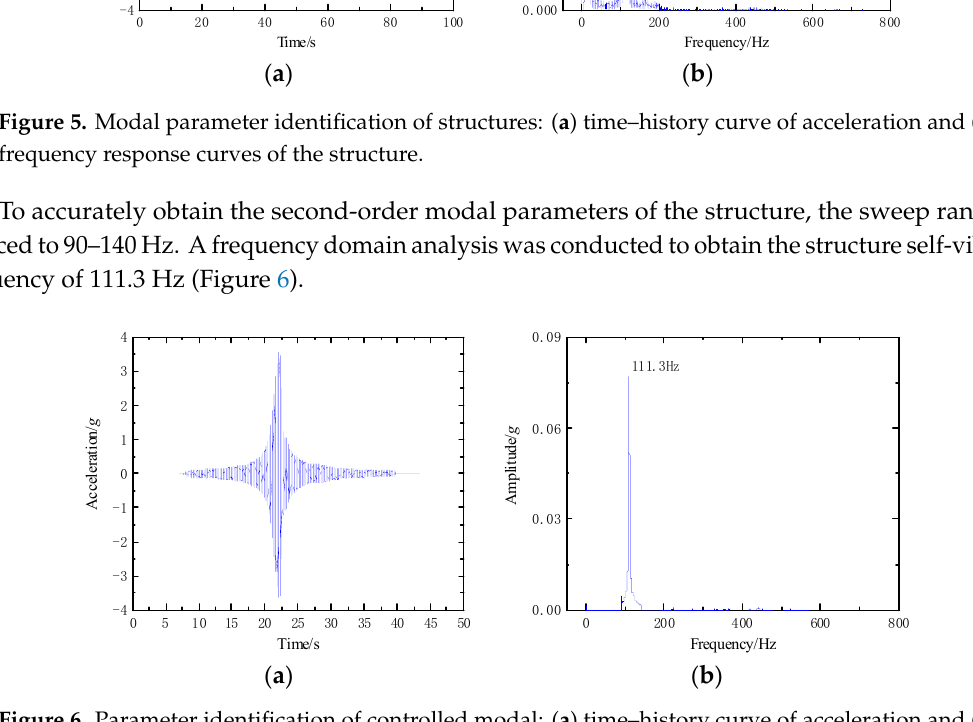
Figure 6. Parameter identification of controlled modal: ( a ) time–history curve of acceleration and ( b ) frequency response curves of the structure.